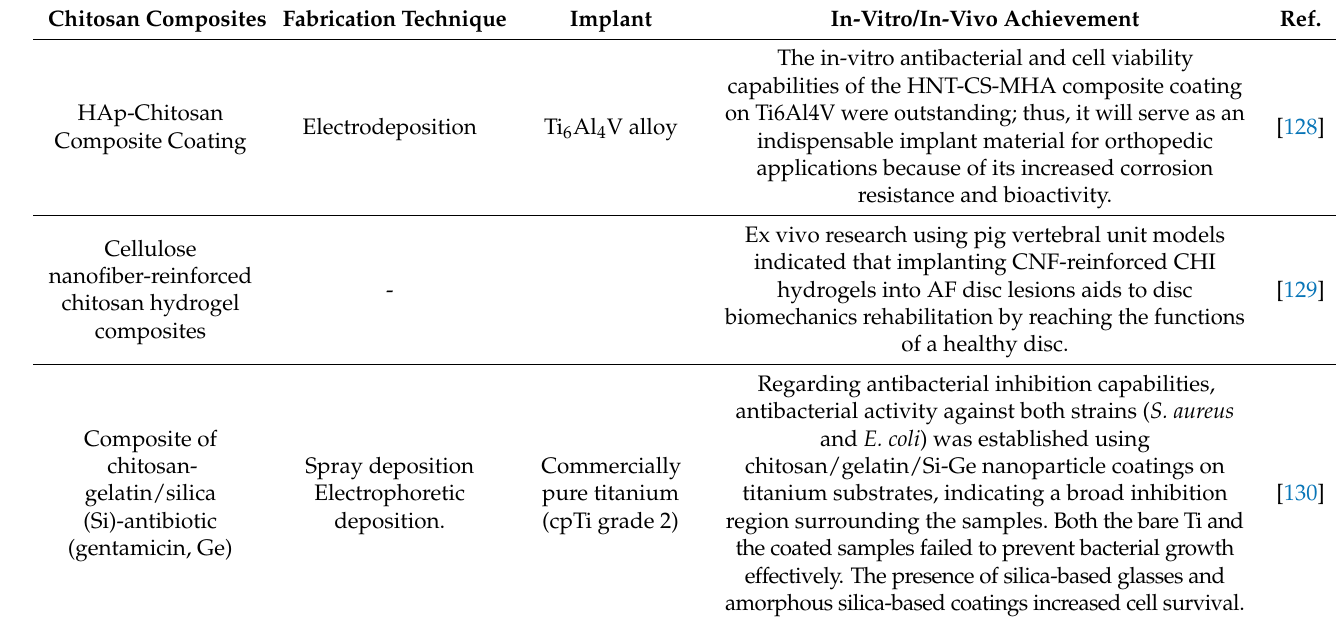
Table 2. Some studies about the application of chitosan composites for